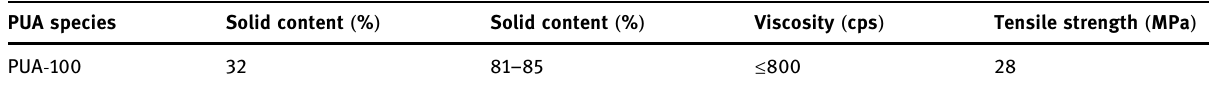
Table 2: Technical properties of PUA PUA